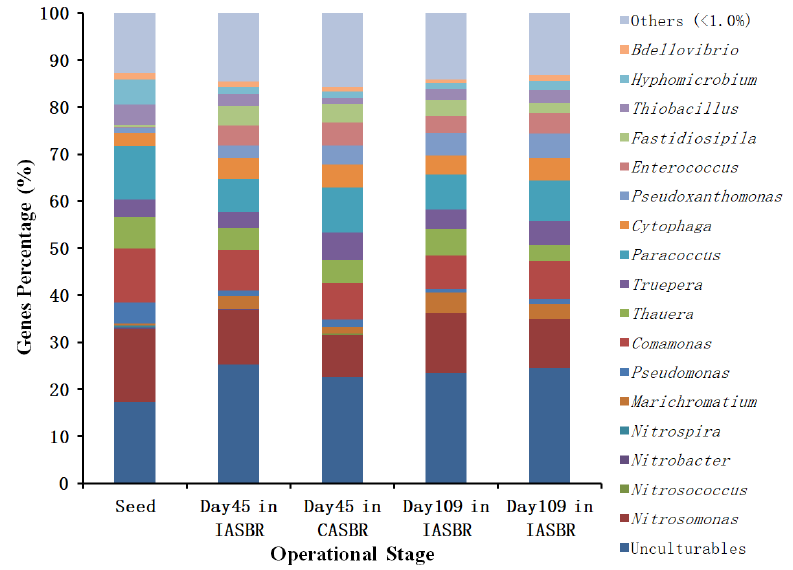
Figure 5. Microbial population analysis of partial nitrification sludge by 16S rRNA gene sequencing.